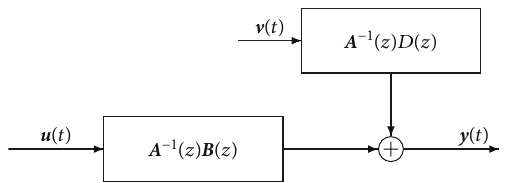
Figure 1: A multivariable controlled autoregressive moving average